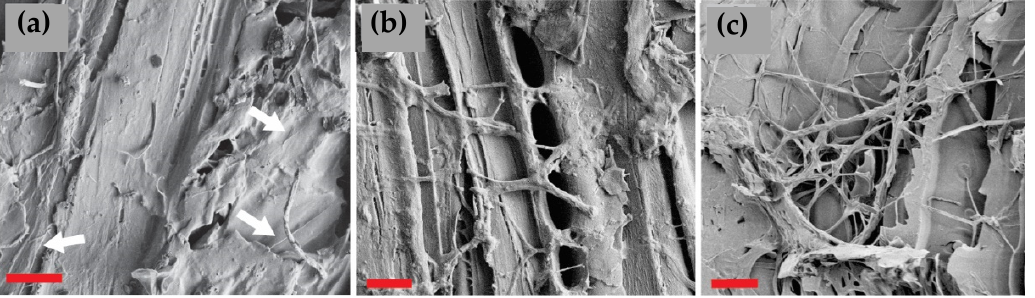
Figure 6. Surfaces of ( a ) SC-CP, with arrows pointing to thin hyphae of C. puteana ; ( b ) SC–TV and